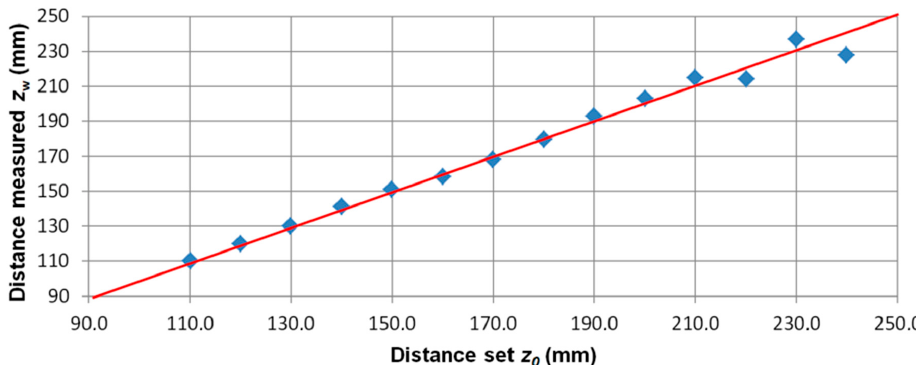
Figure 10. The dependence of the value of the determined distance from the object ( z w ) on the set distance z 0 . Position of the ME8 standard ( x 0 , y 0 , z 0 ) = (0, 0, 110:240) mm. Red line— z 0 value of the